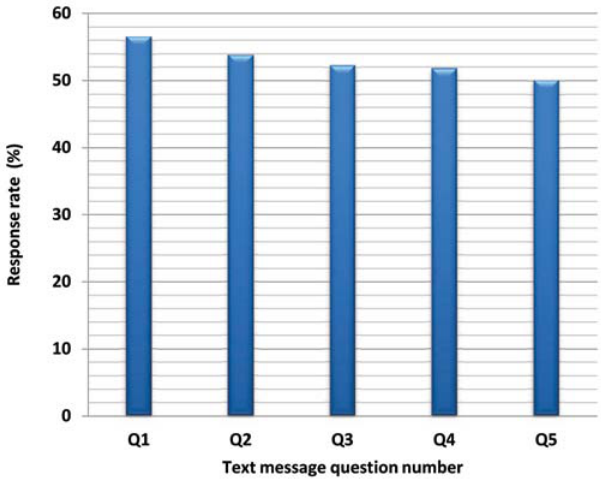
Figure 1. Response rate of each question for text messaging survey.